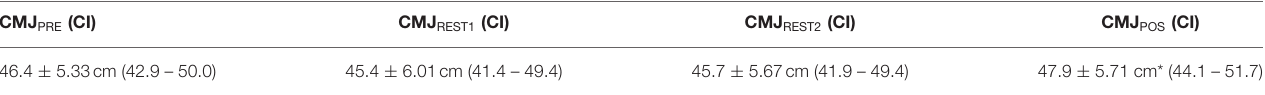
TABLE 3 | Mean and standard deviation of the performance in the countermovement jump test (CMJ) pre, post, and in the interval of the rounds of pace training performed at the intensity corresponding to the kick frequency at the anaerobic threshold ( n = 12). CMJ PRE (CI) CMJ REST1 (CI) CMJ REST2 (CI) CMJ POS (CI)